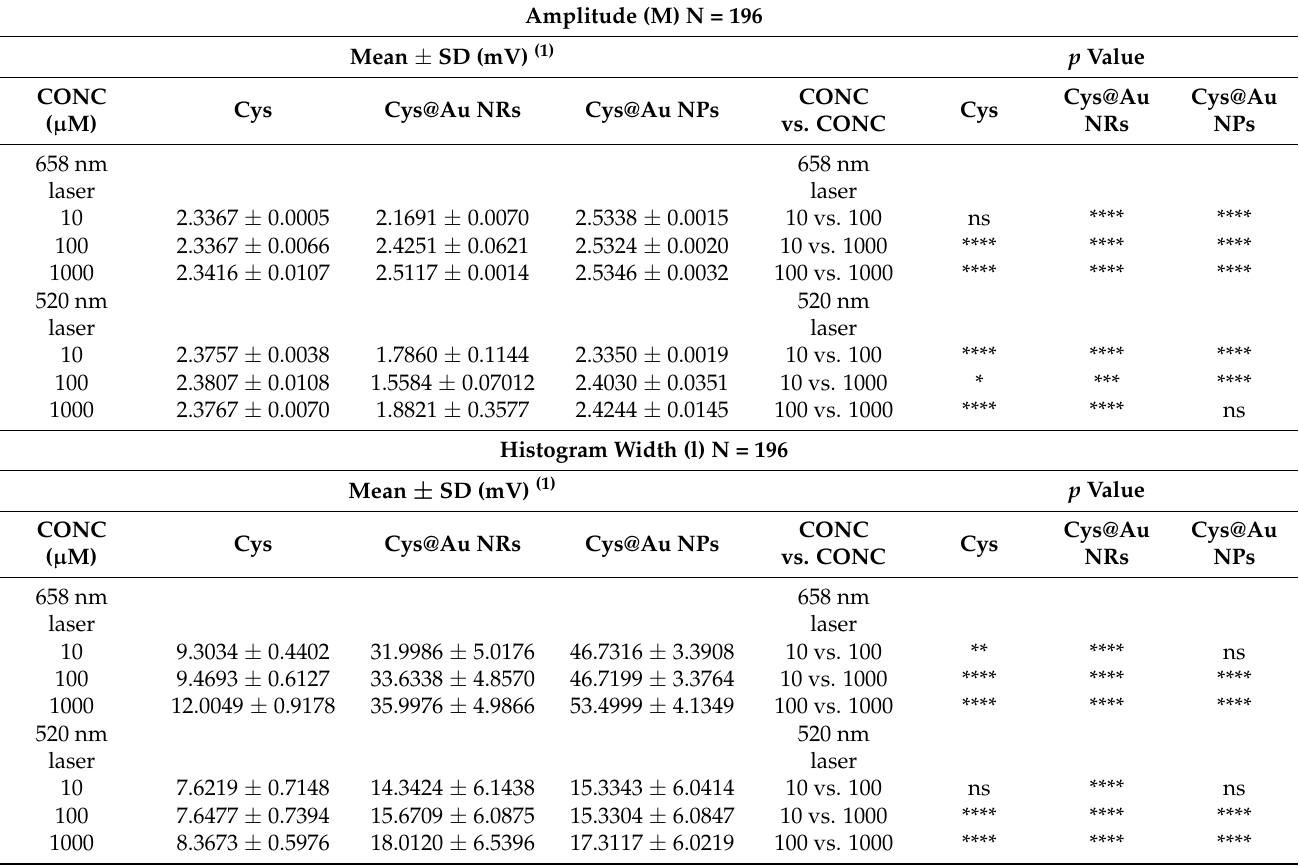
Table 1. Means and standard deviations of PA features (including amplitude (M) and histogram width (l)) with Bonferroni’s multiple comparison post-hoc test, to provide the interactive relationships between the factors and three